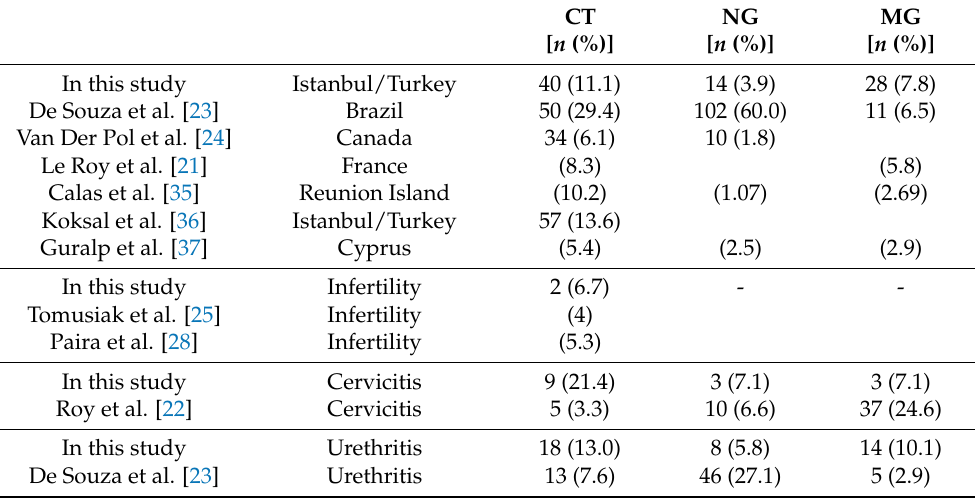
Table 5. Distribution of prevalence data of different